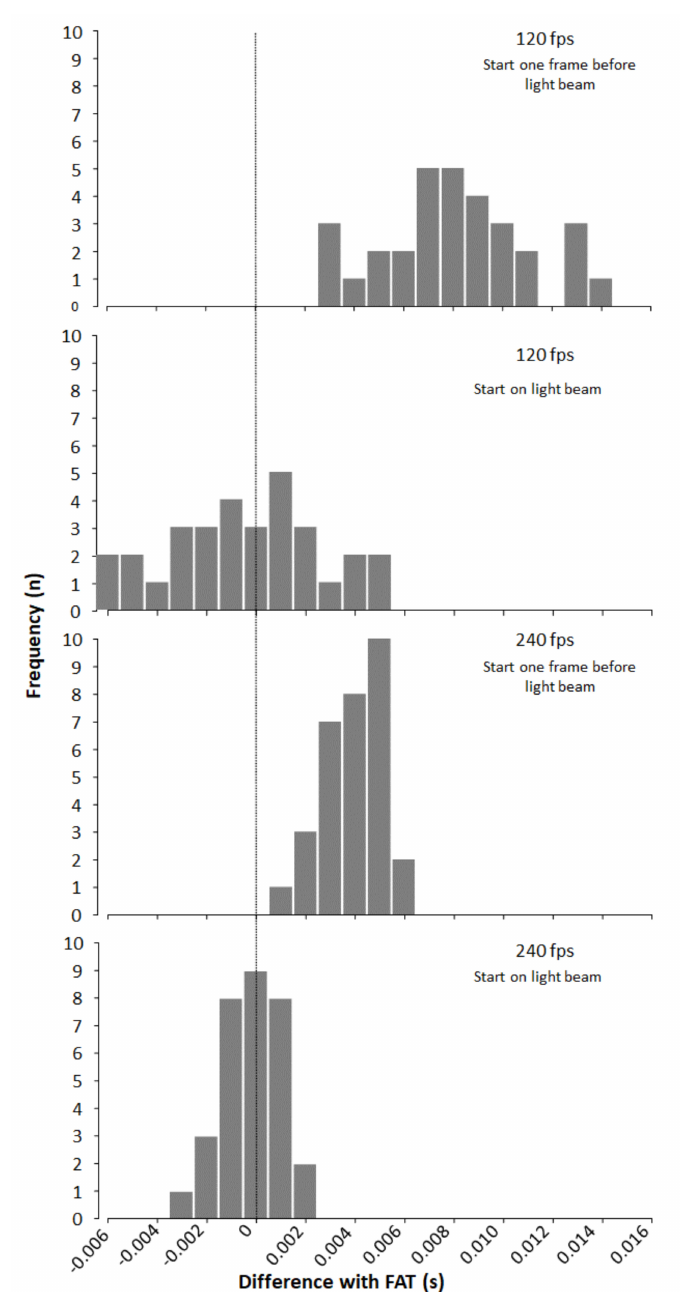
Figure 2. Difference between iPhones and the